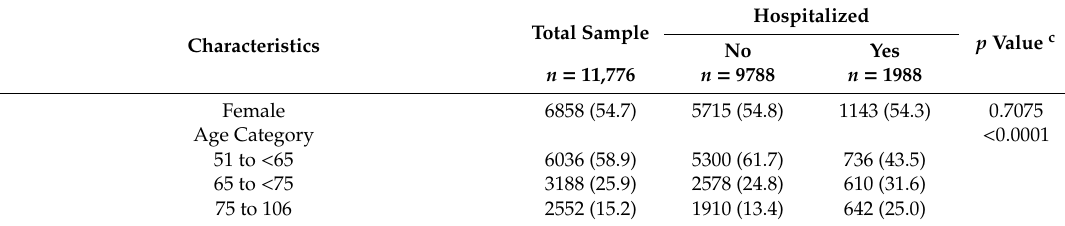
Table 1. Descriptive statistics by 2014 hospitalization status a,b